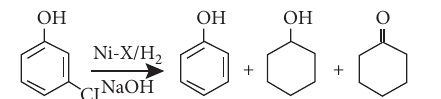
2 ; (b) Ni-ZnO; and (c) Ni-VPO.